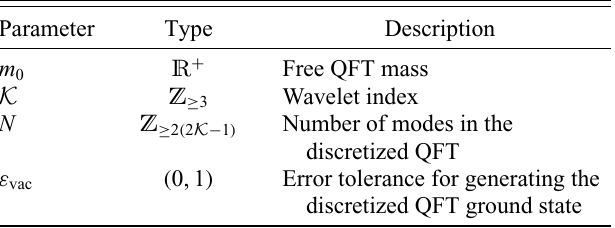
TABLE II. Inputs from the main server to the ground-state- generation server.